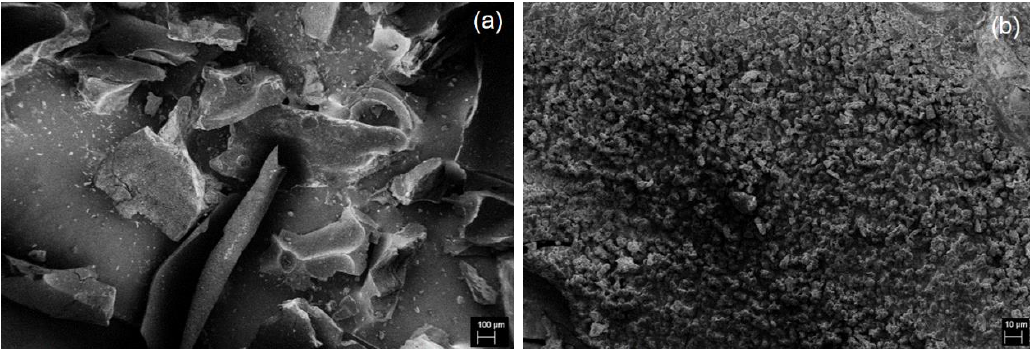
Figure 3. SEM images of GCF at ( a ) 100× and ( b ) 1000× magnification.